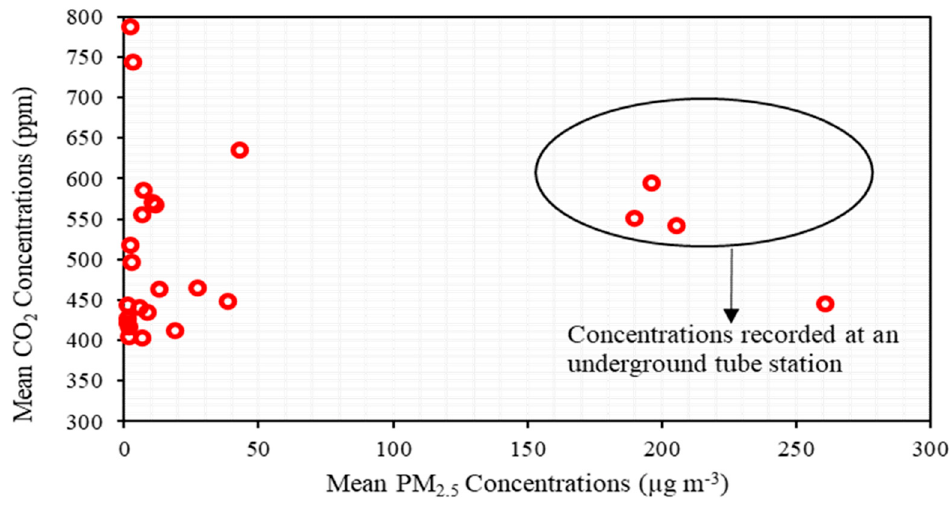
Figure 4. Comparison of mean CO 2 and PM 2.5 concentrations from all sites to highlight the lack of correlation between the sources of CO 2 and PM 2.5 .